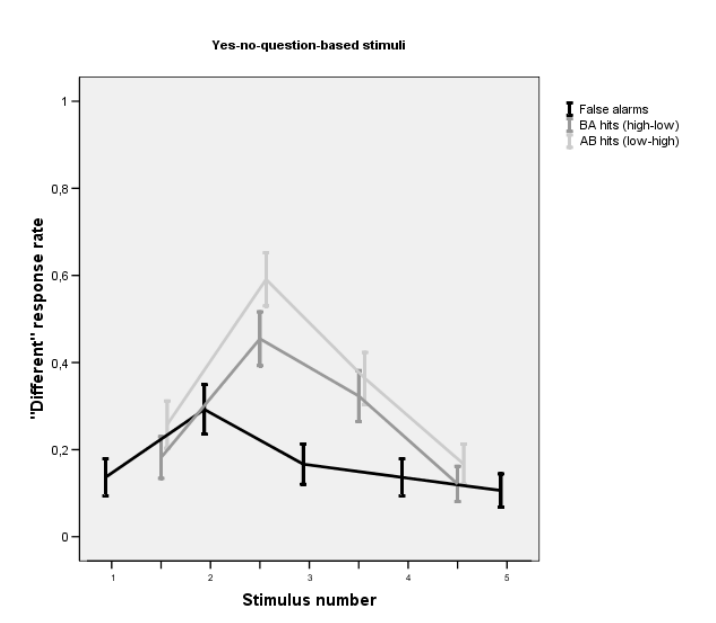
Figure 6. Rate of “different” responses for pairs that were actually different (hits) and pairs that were identical (false alarms) corresponding to the continuum created from the yes-no question base stimulus. Error bars represent standard error of the